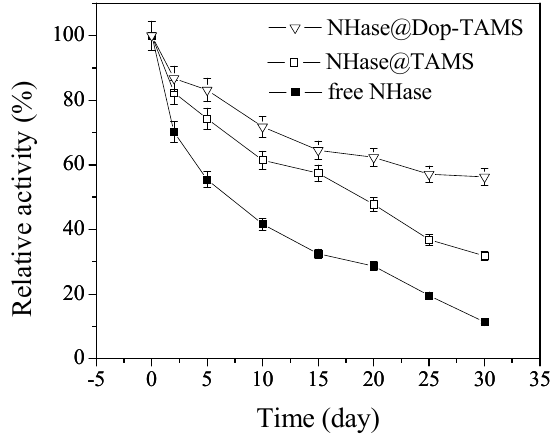
Figure 8. The storage stability of free and immobilized NHase.